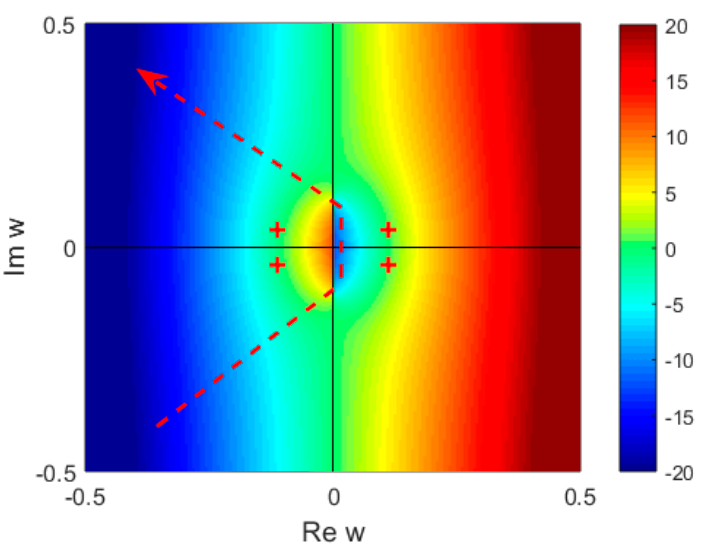
Figure 1. Color map of the exponential in Equation (29), with the steepest descent path, and poles of the integrand. Remote Sens. 2018 , 10 , x FOR PEER REVIEW